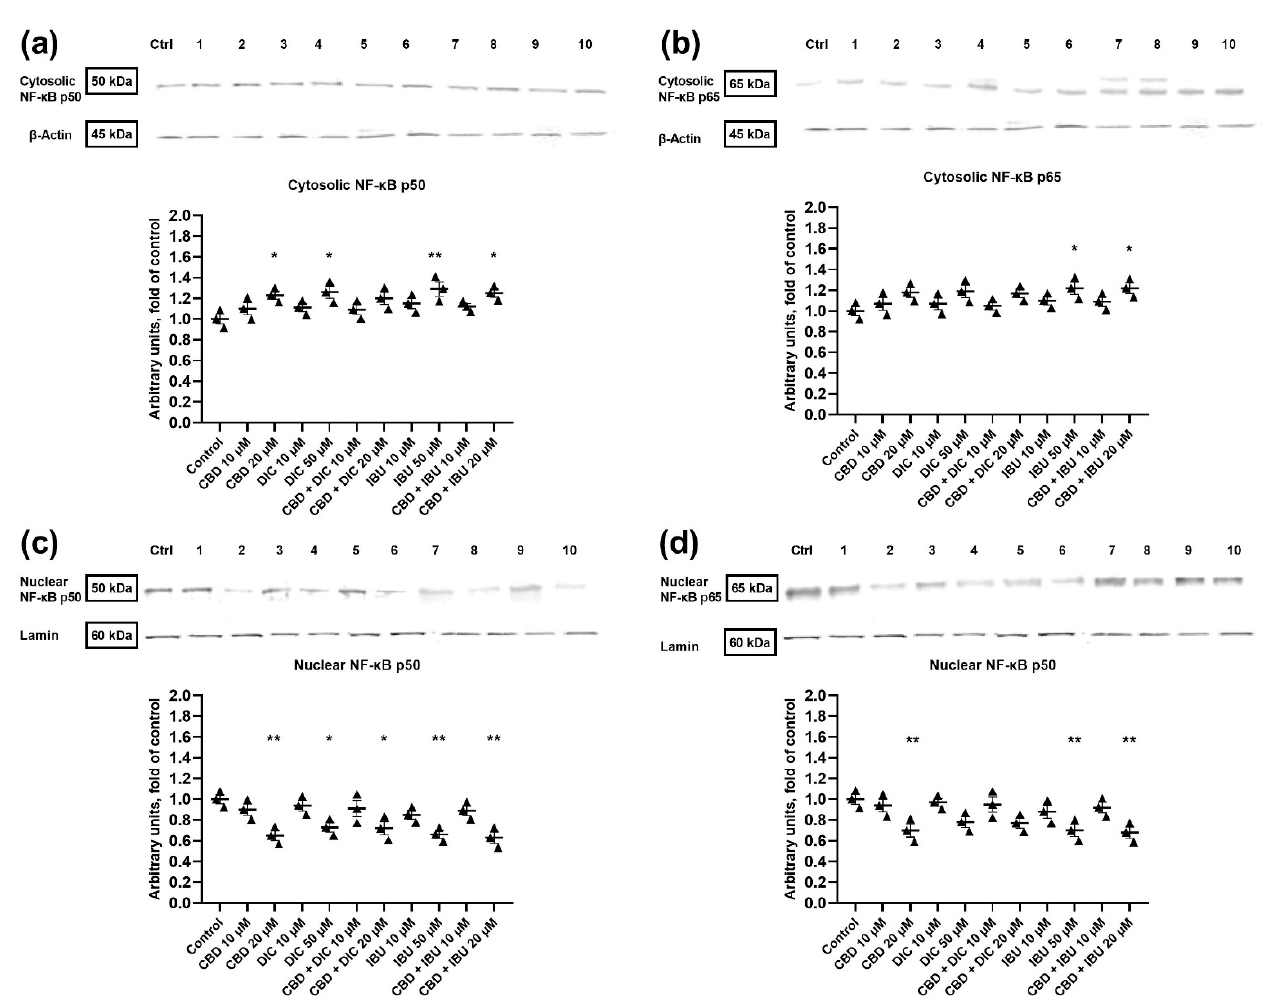
Figure 5. The effect of CBD and its combinations with DIC and IBU on the level of NF- κ B p50 and p65 proteins (in the cytosolic fraction—panel ( a ) and ( b ); in the nuclear fraction—panel ( c ) and ( d )) in A431 cells. Representative Western blots are presented above the graphs. The numerical code follows the order of compounds presented in charts, i.e., Ctrl —Control, 1 —CBD 10 µ M, 2 —CBD 20 µ M, 3 - DIC 10, 4 DIC—50 µ M, 5 —CBD + DIC 10 µ M, 6 —CBC + DIC 20 µ M, 7 —IBU 10 µ M, 8 —IBU 50 µ M, 9 —CBD + IBU 10 µ M, 10 —CBD + IBU 20 µ M. The values (mean ± SEM) were calculated as a relative change in the protein level compared to control cells from three separate experiments. * p < 0.05 and ** p < 0.01 mean values significantly differed from the control group. Original scans of blots are shown in Supplementary Materials Figure S2.